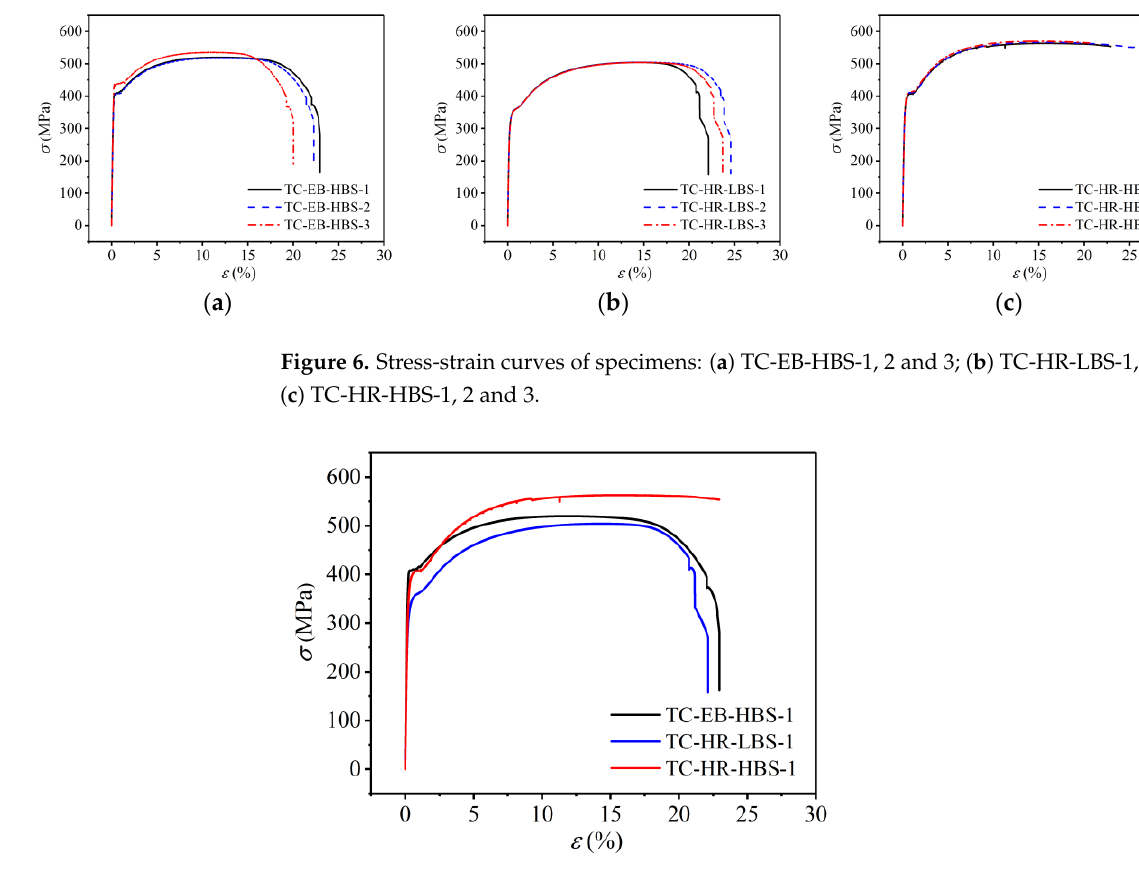
Figure 7. Comparison of typical experimental stress-strain curves for different kinds of the speci- mens.